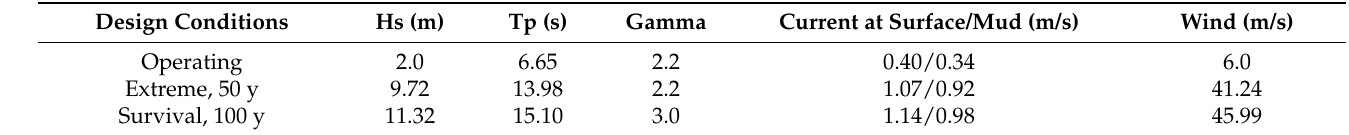
Table 1. Metocean Conditions.